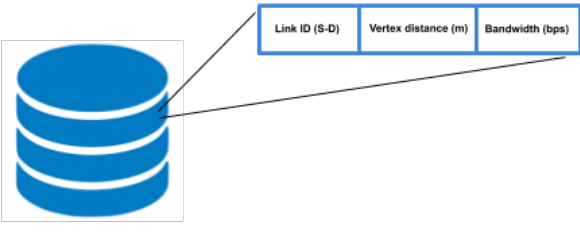
Figure 2. New record of LSA